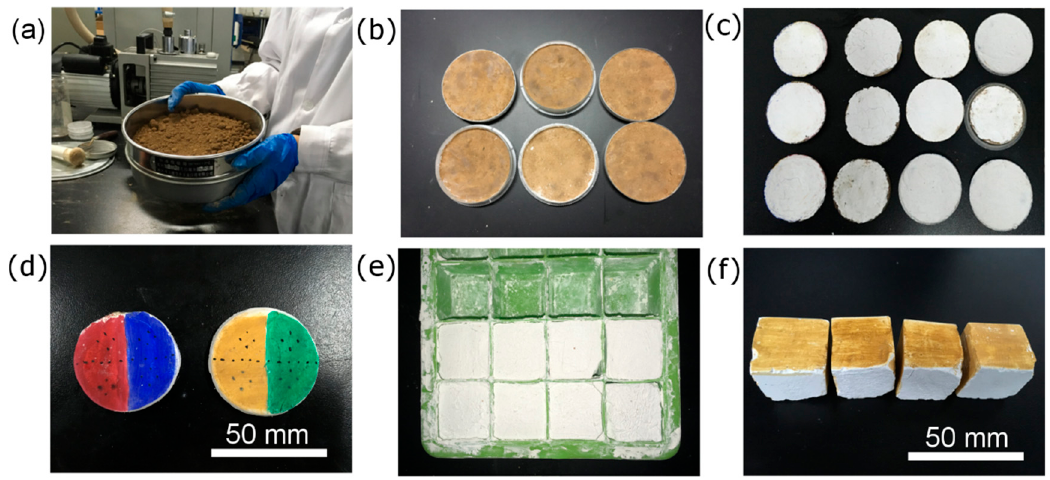
Figure 2. Preparation procedures of the simulating samples: ( a – d ) Preparing the rounded samples. ( e , f ) Preparing the cubic samples. ( e , f ) Preparing the cubic